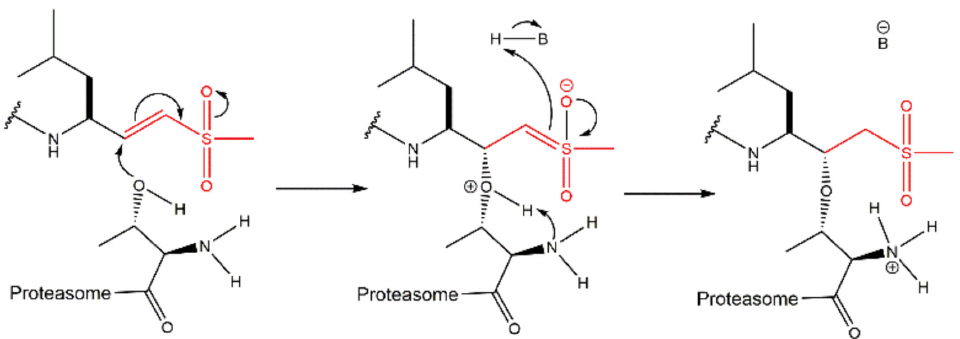
Figure 15. Mechanism of proteasome inhibition by a peptide vinyl derivate inhibitor, in the example, with sulfone as an electron withdrawing group and which function as Michael acceptor of the hydroxyl group from Thr1